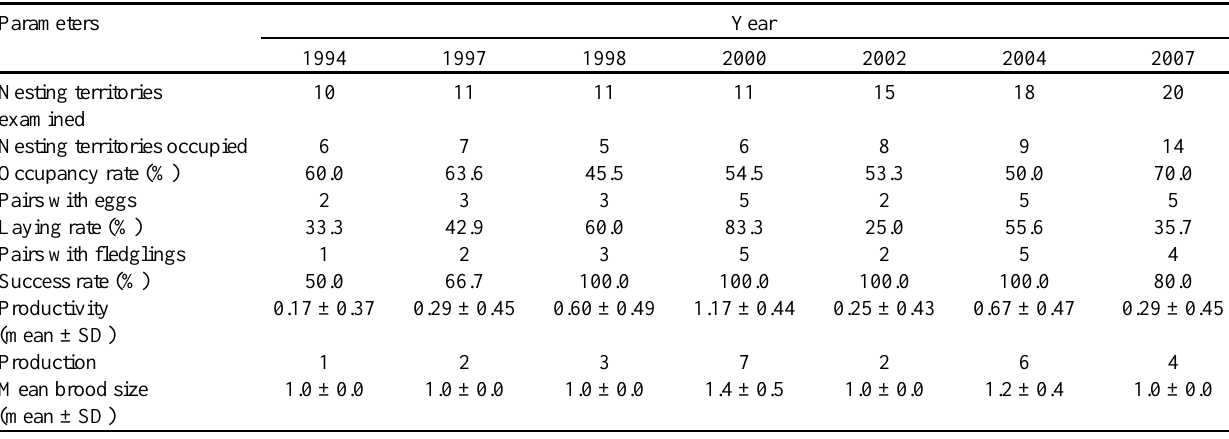
Table 2 . Summary of reproductive characteristics of Golden Eagles ( Aquila chrysaetos ) in the Sainte-Marguerite and Moisie River valleys,